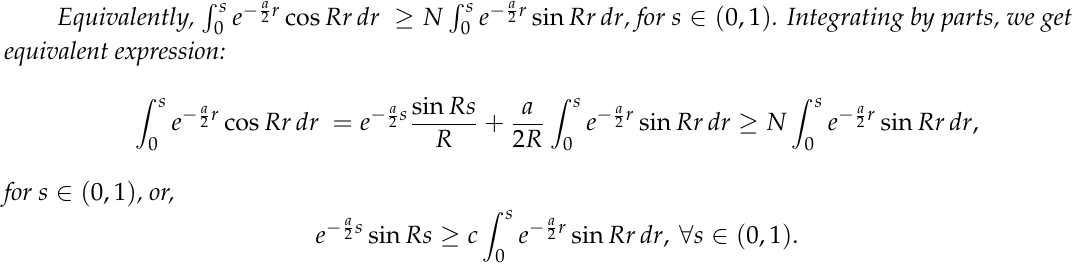
Figure A3. Graph of the function h (cid:48) corresponding